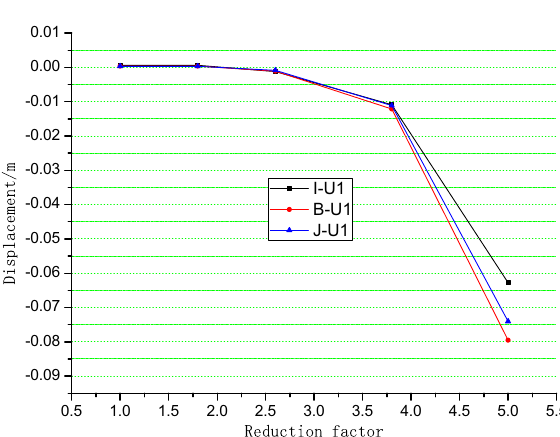
Figure 11. Displacement of monitoring points A to E vs. reduction factor.